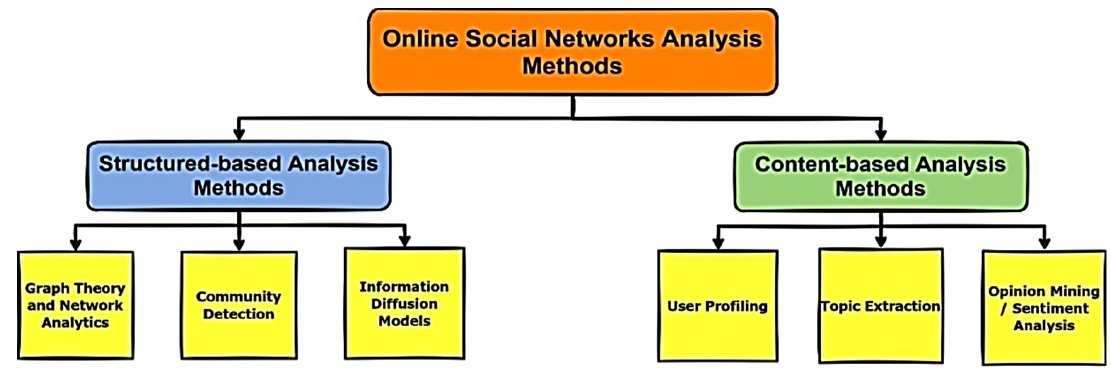
Figure 1. Social media data-based research classification in the literature.